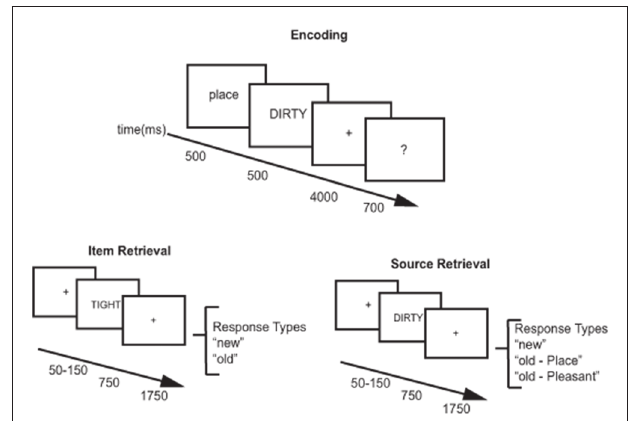
FIGURE 1 | Behavioral paradigm. Encoding (top panel) for the item and source retrieval tasks used the same procedure. Participants were shown a 500 ms cue indicating which encoding task to use (pleasantness or place) followed by presentation of an adjective for 500 ms. They were given 4000 ms to perform the encoding task followed by a 700 ms question asking how well they felt they encoded the word. During item retrieval (bottom left) and source retrieval (bottom right), participants were shown a variable fixation cross (50–150 ms) followed by presentation of the adjective to be retrieved for 750 ms. A 1750 ms fixation cross followed adjective presentation. Participants could respond any time after the adjective was presented. During the item retrieval task responses were either old or new. During the source retrieval task responses were old place, old pleasant, or